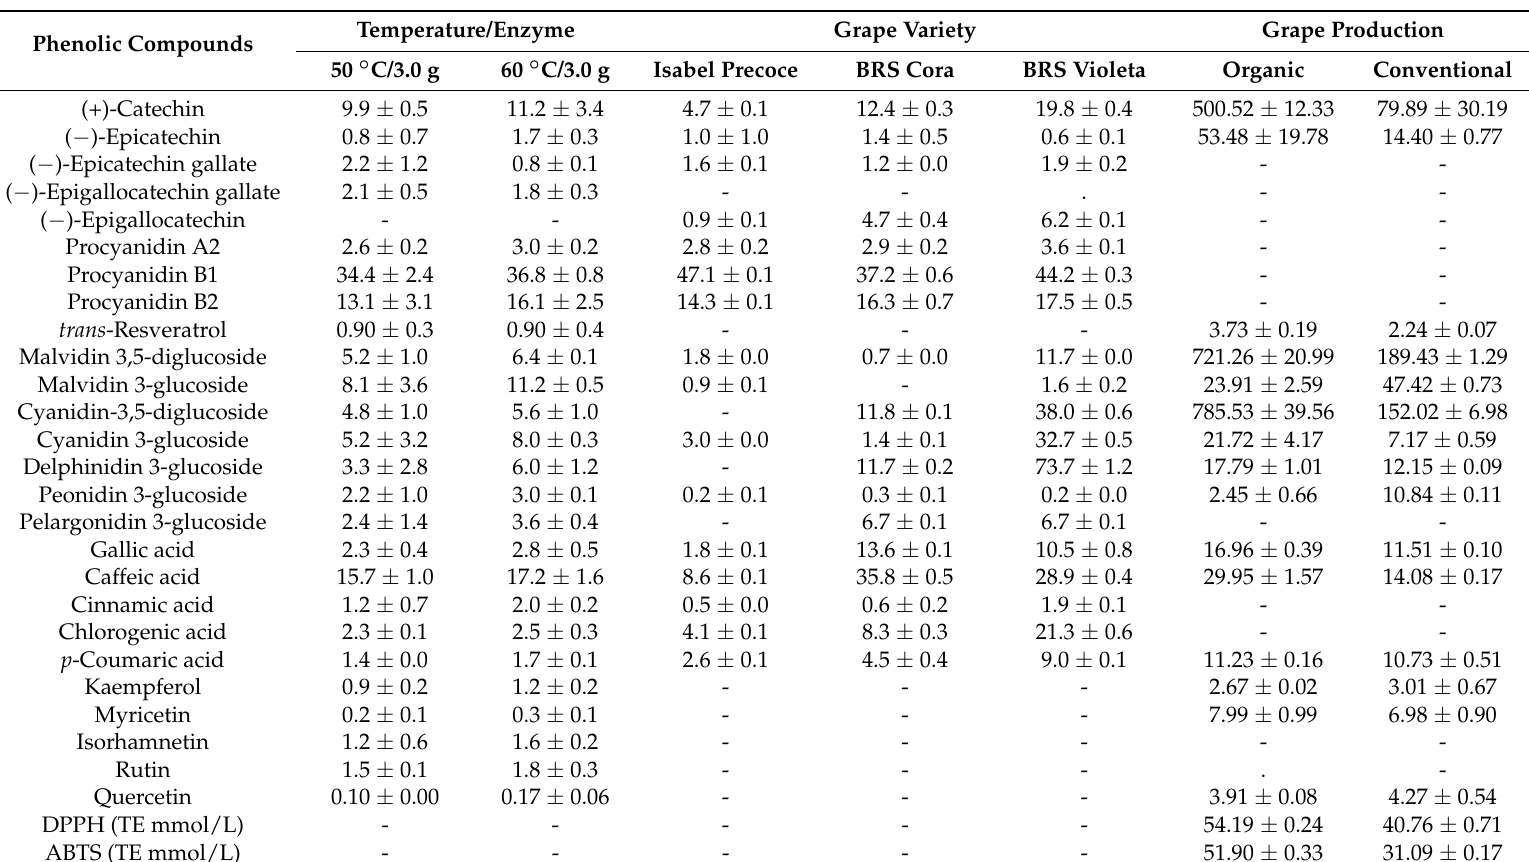
Table 1. Phenolic compounds (mg/L) from grape juice obtained in different conditions of maceration, from different grape varieties and from organic and conventional grape production